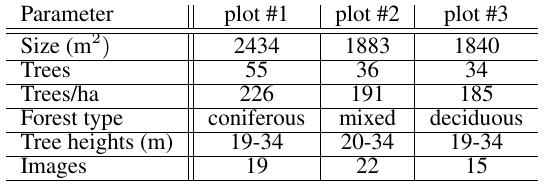
Table 1. Parameters of reference plots.